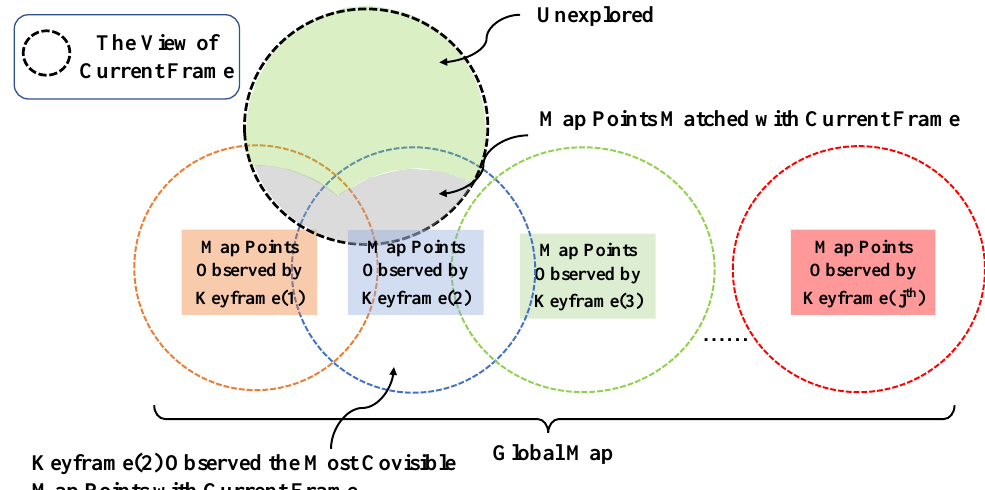
Figure 3. Keyframe selection criteria.